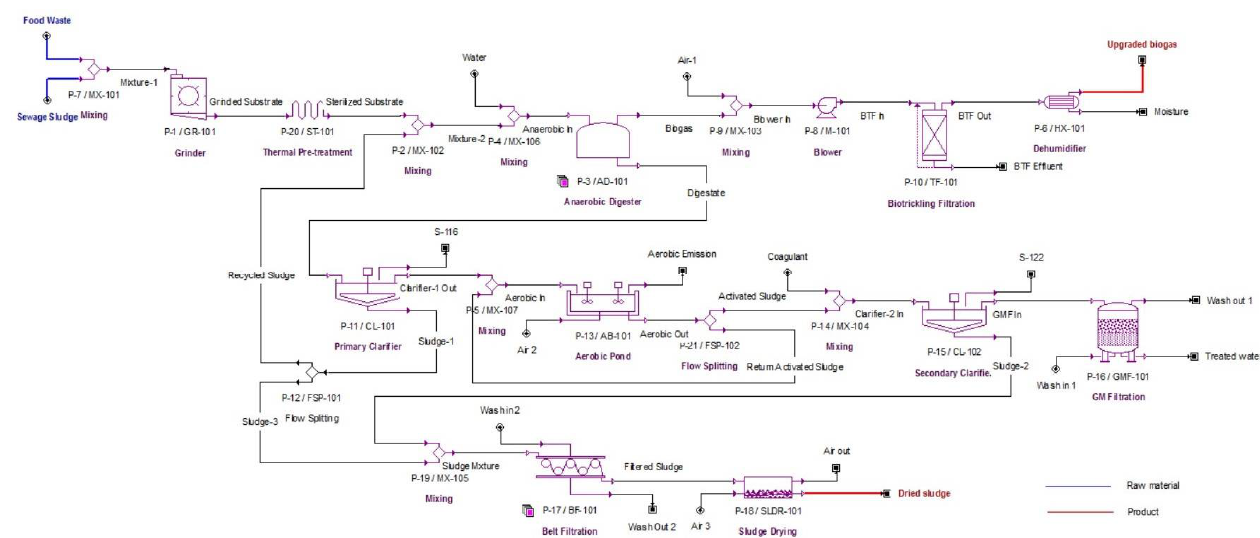
Figure 1. Simulation flowsheet for anaerobic co-digestion of food waste with sewage sludge.